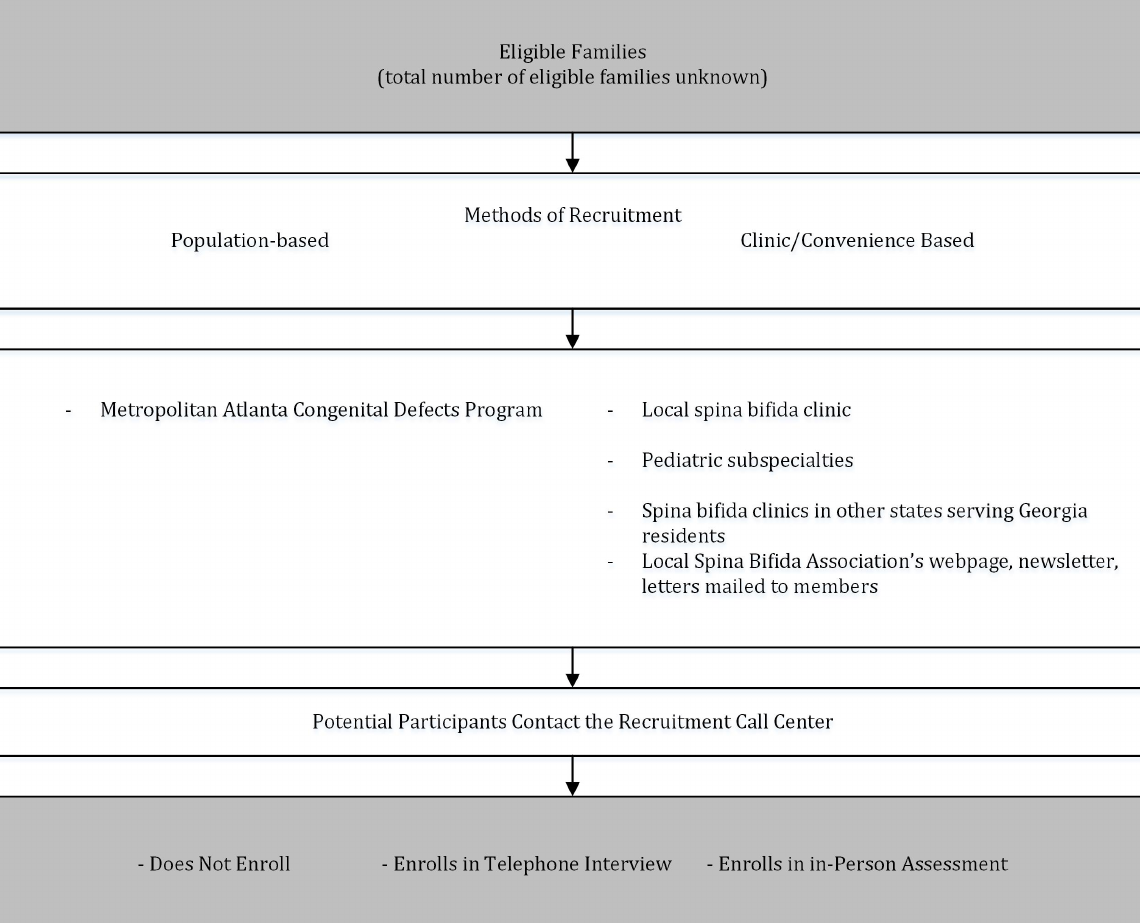
Figure 1. Recruitment